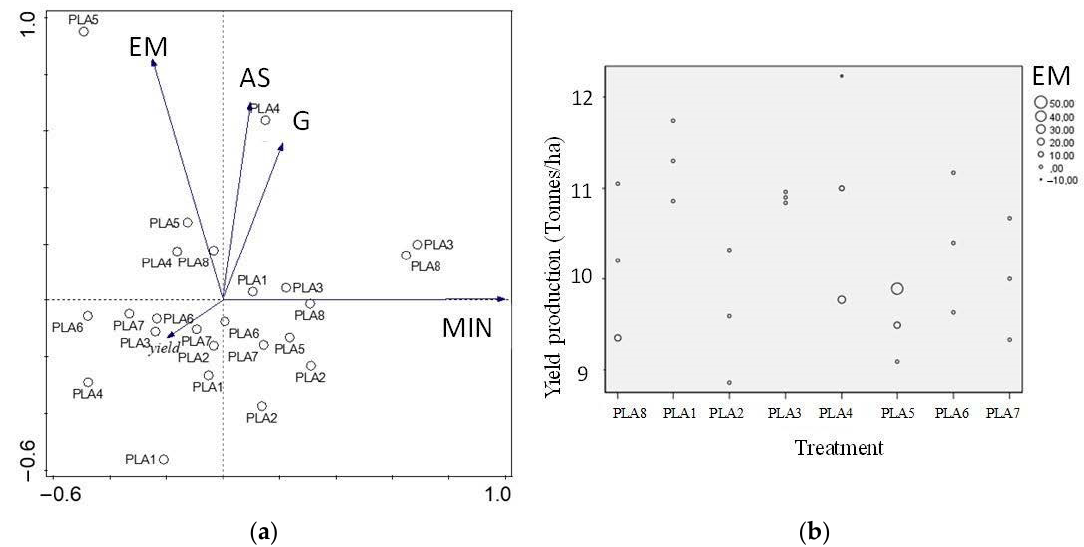
Figure 2. ( a )Variables and treatments under the factorial plan, after a principal component analysis (PLA 1–8, 1: 0.1%, 2: 0.25%, 3: 0.5%, 4: 0.75%, 5: 1%, 6: 3%, 7: 5 %, 8:0%); EM: Earthworm mortality, AS: Aggregate stability, MIN: Nitrogen mineralization rate; ( b ) Plant yield production and earthworm mortality rate (EM) under PLA with compost.